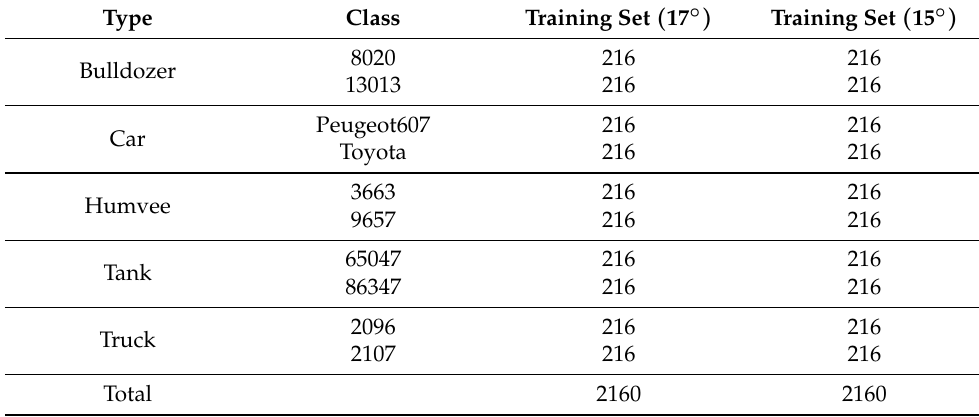
Figure 3. Examples of the targets in the SARSIM dataset. Table 2. Details of the training set of the SARSIM dataset used in this